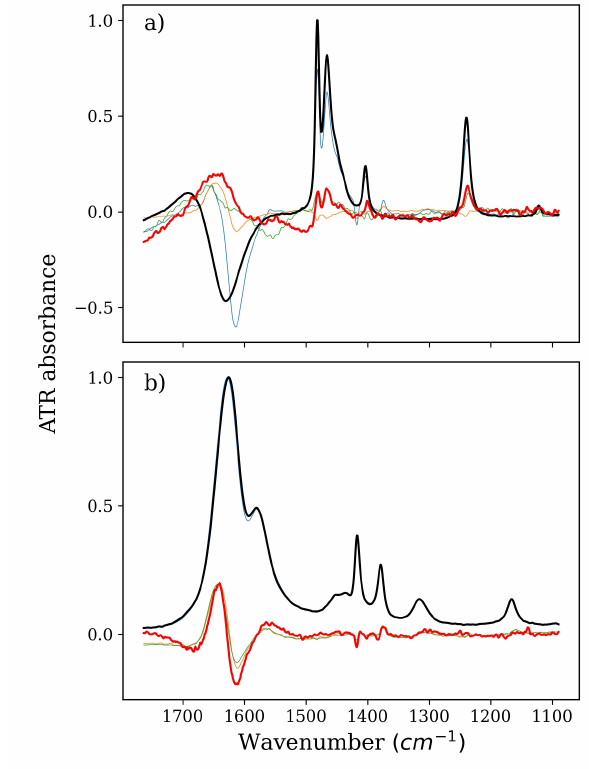
Figure 1. Spectra of pure TMAO or NMA solution (thick black lines), derivatives, i.e., spectral representation of changes in pure solutions of TMAO or NMA caused solely by their concentration increase (thick red lines), and isolated spectra of factors from a series devoid of ( a ) water and NMA or ( b ) water and TMAO (all other thin lines). Part ( a ), therefore, denotes TMAO, and Part ( b ) denotes NMA, both corresponding to the green and magenta series in Figure 6b, respectively. Absorbance is arbitrary; spectra intensities were adjusted to fit into one